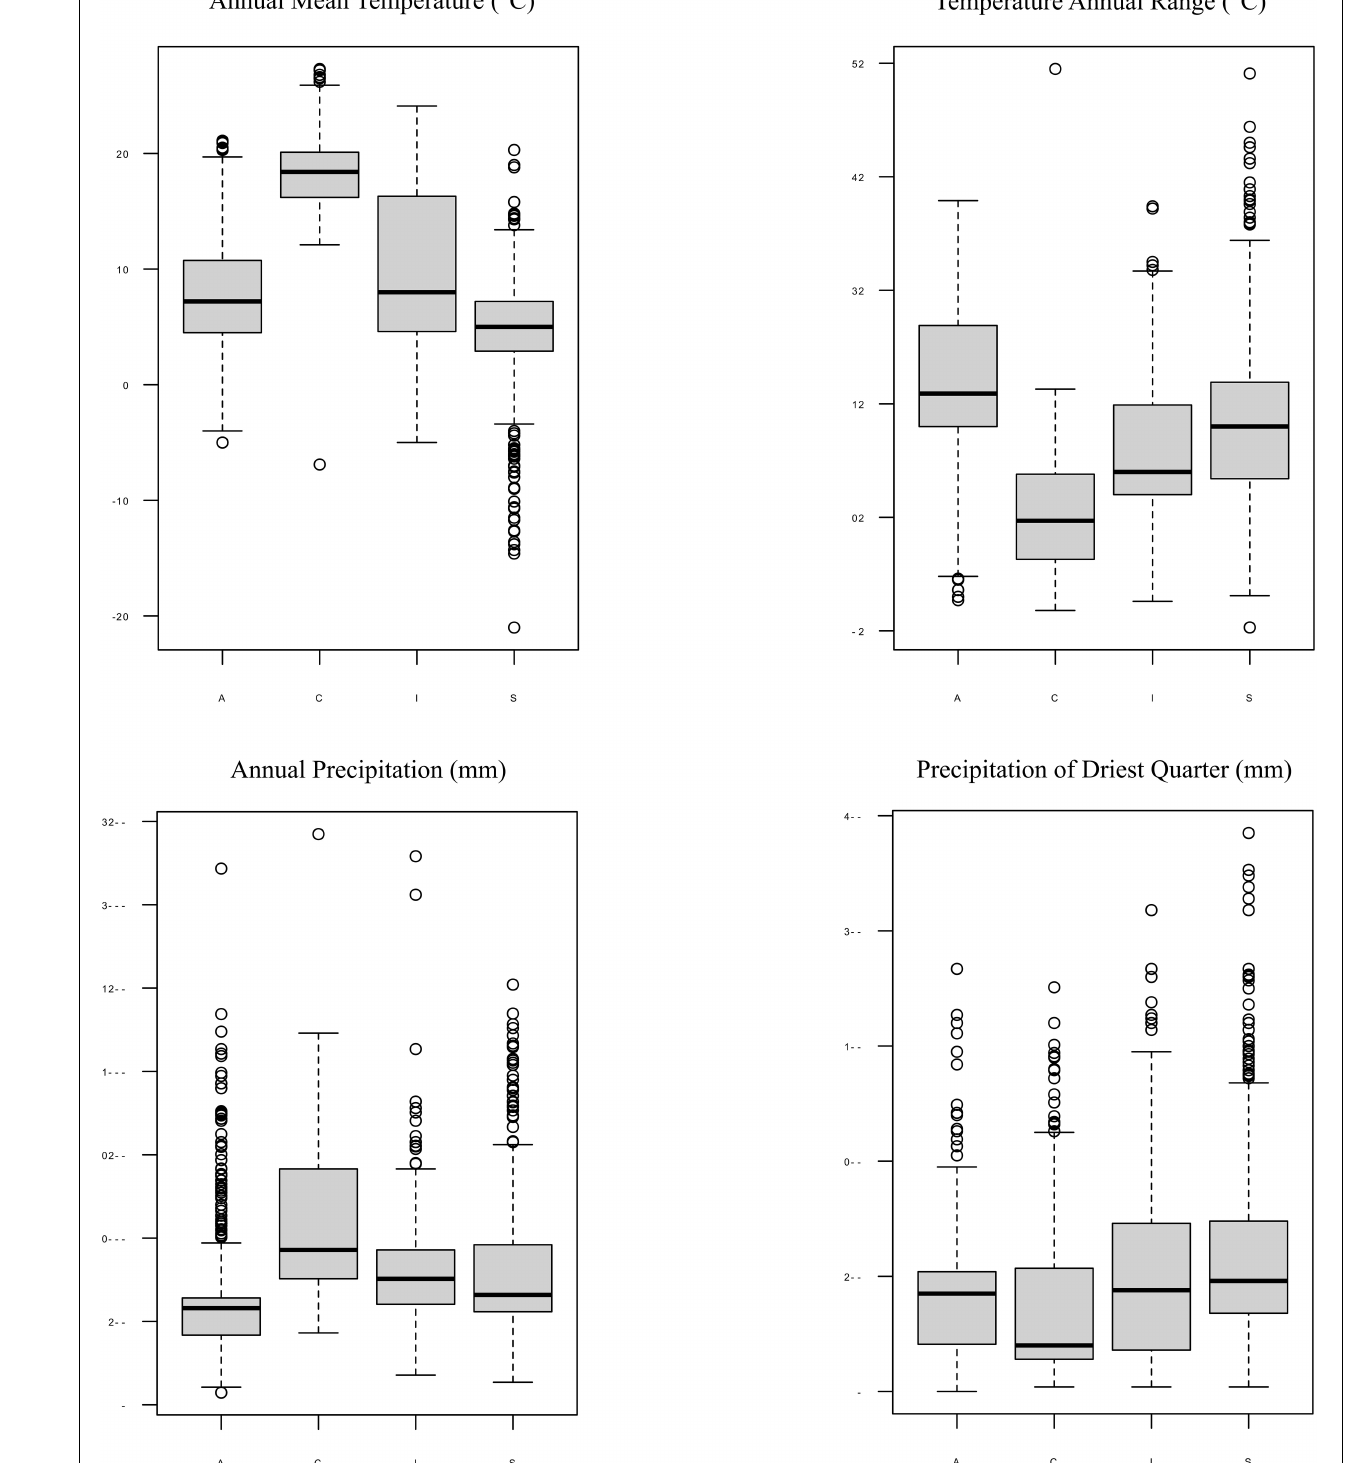
Frontiers in Microbiology |